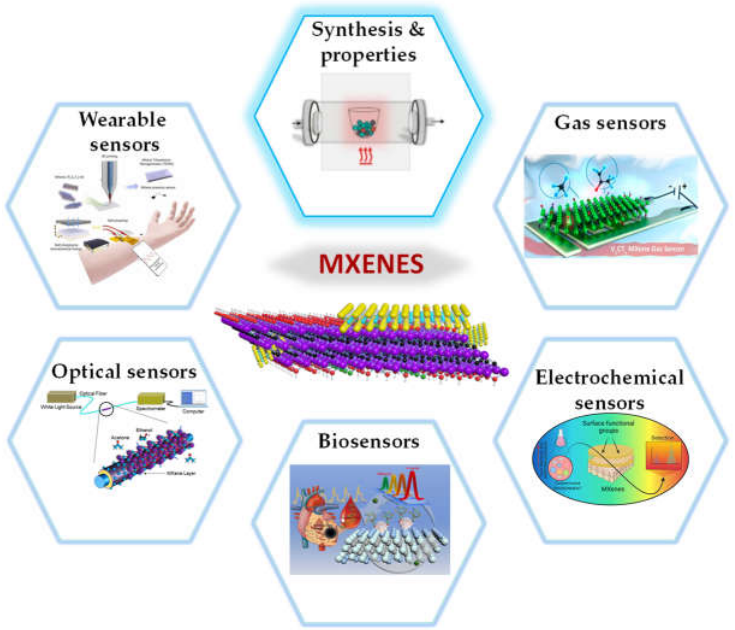
Figure 1. An overview of the applications of MXenes in the sensor, including gas sensors, electro- chemical sensors, biosensors, optical sensors, wearable sensors, and synthesis & properties.